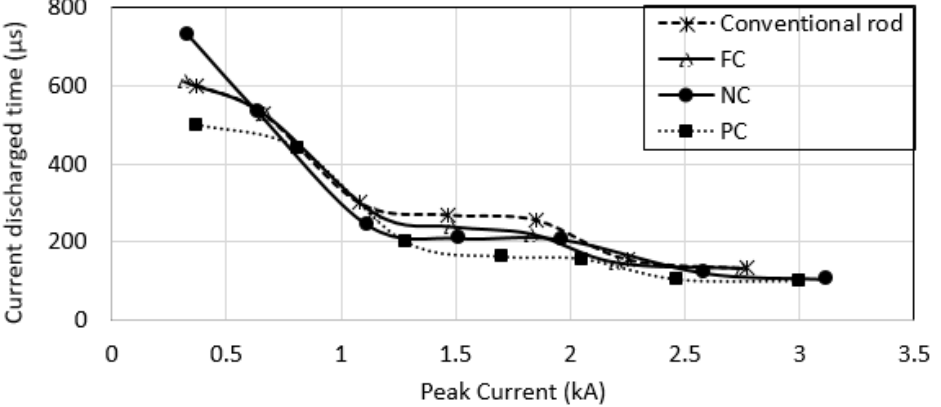
Figure 9. Current discharged times for all tested electrodes vs. peak current .